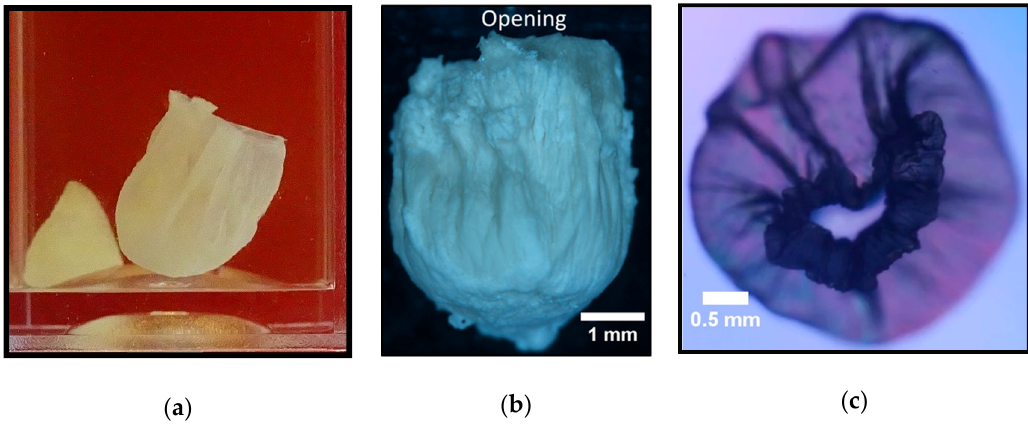
Figure 7. ( a ) Barium vesicle sinking at the bottom of the cuvette (the width of the cuvette is 1.25